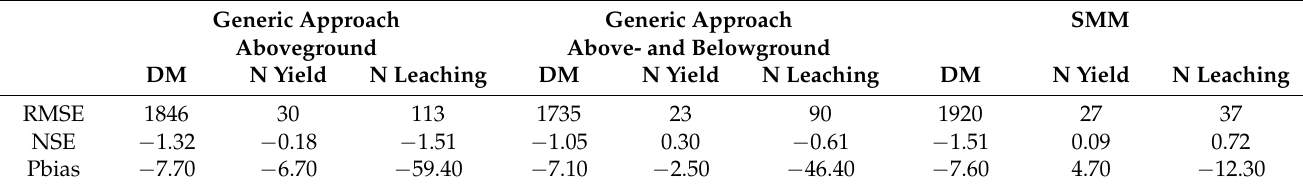
Table 4. Model performance statistics for forage maize dry matter (DM) ( n = 18) and nitrogen (N) yield ( n = 18) as well as N leaching ( n = 18) for the continuous maize and maize following grass-clover ley at low, standard, and high N fertilization levels for experimental site 2; RMSE = root